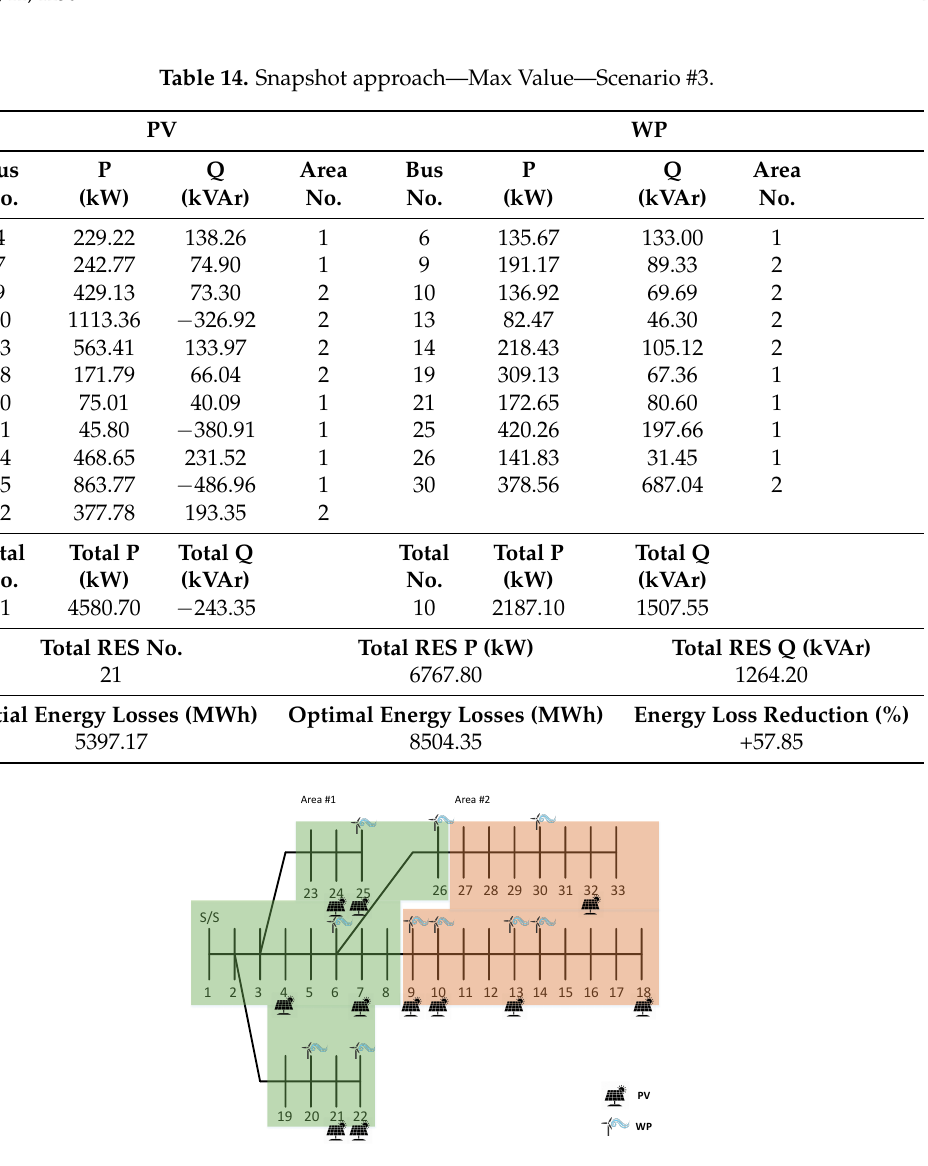
Figure 24. Snapshot Approach—Max Value—Scenario #3 solution.